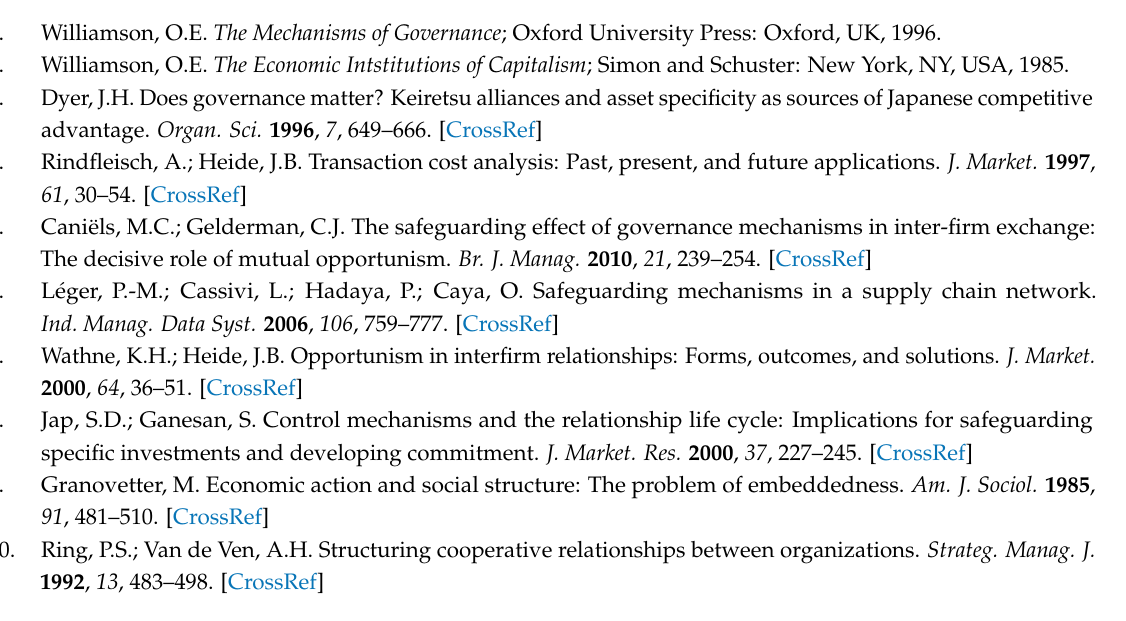
Table S1: Number of articles by